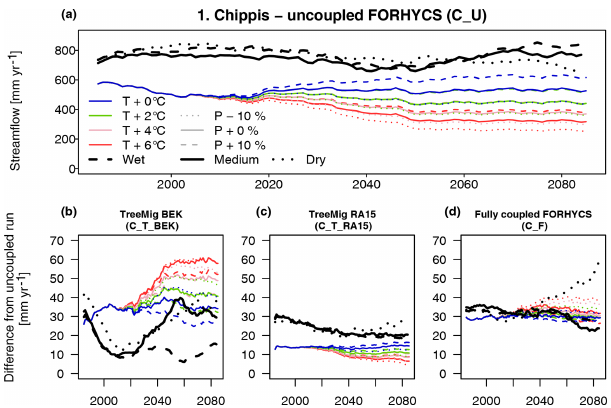
Figure 10. (a) Simulated annual streamflow (30-year rolling means) in the Chippis subcatchment (lowest elevation; most forested). In the warmest dry delta change scenario (T6_P-10), annual stream- flow is reduced approximately by half, from 550 to less than 300mmyr − 1 . (b, c) Difference in annual streamflow in the runs with one-way coupling, relative to the uncoupled run. (d) Differ- ence in annual streamflow in the fully coupled FORHYCS run, rel- ative to the uncoupled run. In all coupled runs, streamflow is greater than in the uncoupled version, due to lower LAI (see Figs. 8 and 9; the standard PREVAH value for forest LAI is 8) and, for the fully coupled version, smaller rooting zone storage capacity SFC.